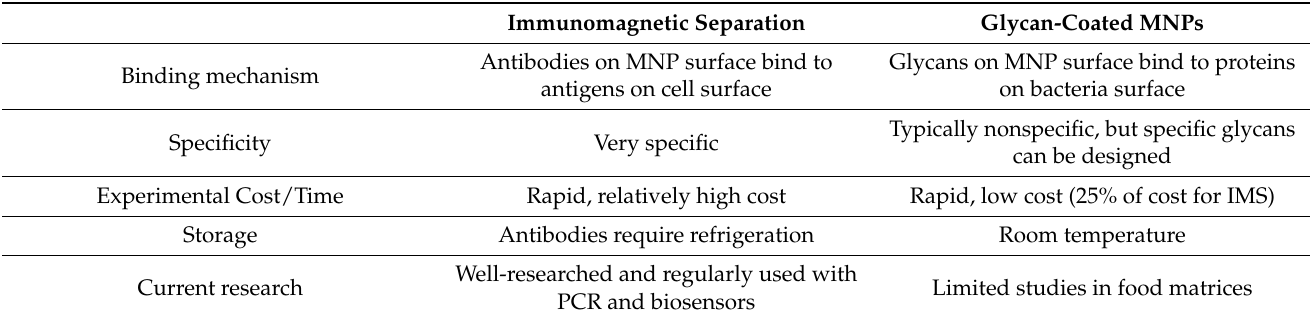
Table 3. Immunomagnetic separation versus glycan-coated